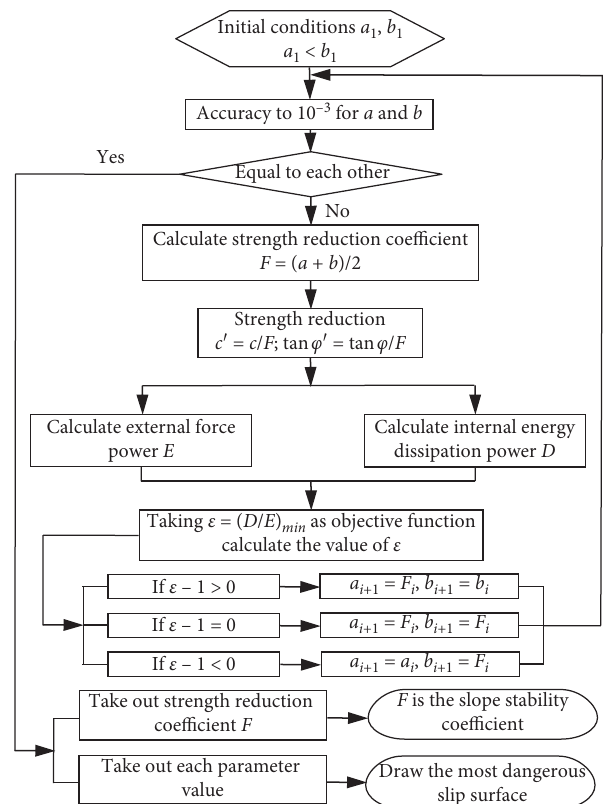
Figure 3: Calculation process of upper bound limit